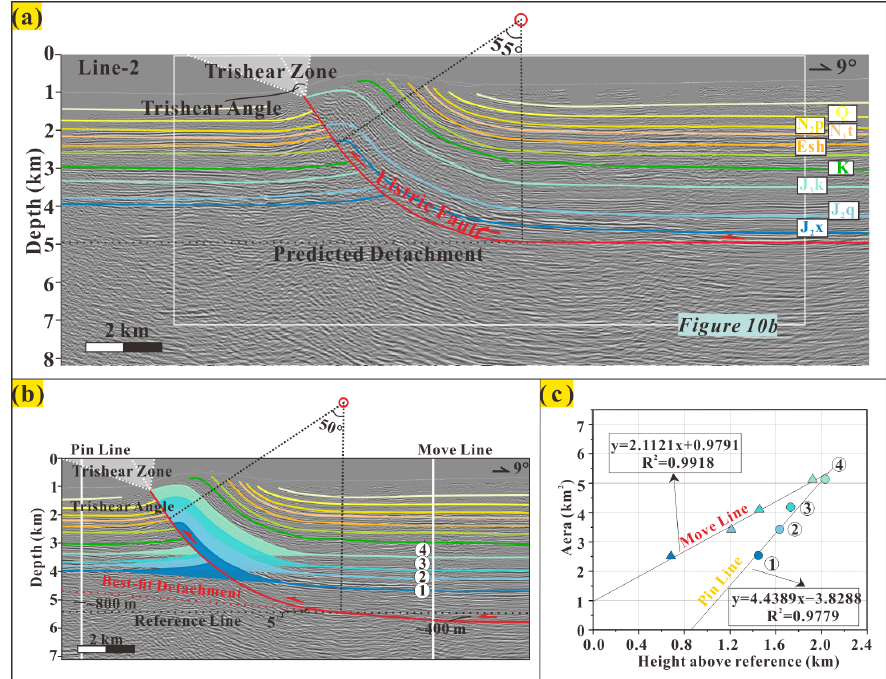
Figure 9. Seismic interpretation and ADS analysis of Line 1 (location in Figure 2a). ( a ) Interpretations of the seismic reflection profile. Vertical exaggeration is 1:1. ( b ) Areas and heights measured for horizons 1–4. ( c ) Area-depth diagram illustrating the area-depth relationships on both move lines and pin lines with R 2 values of >0.99.